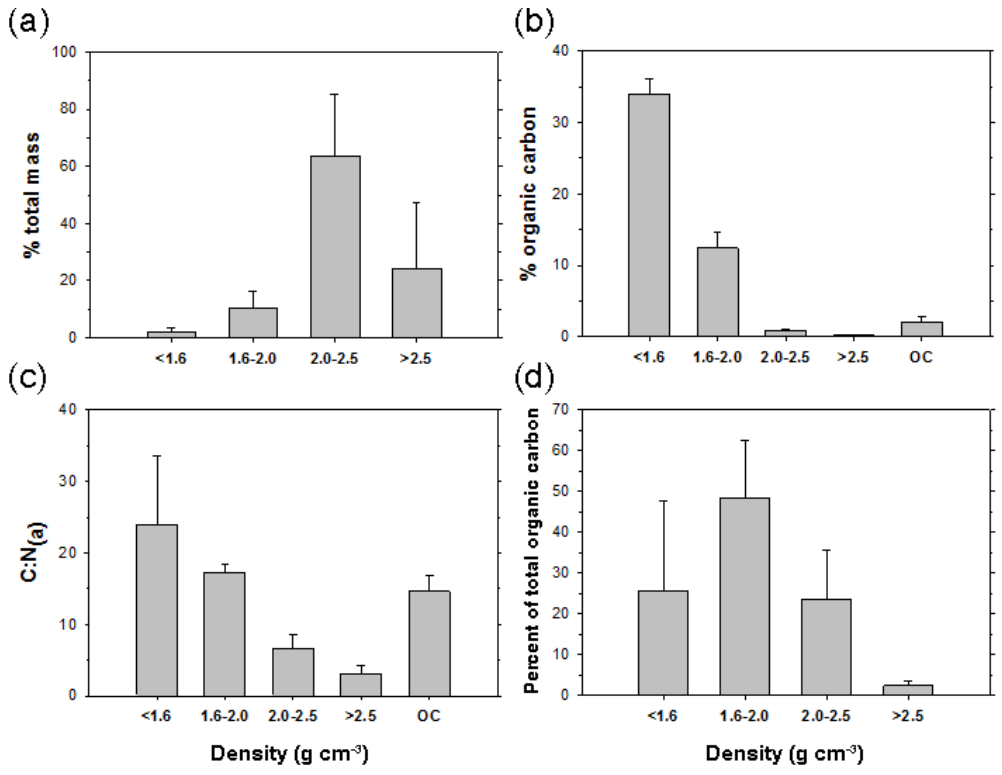
Figure 3. Mean and standard deviations of distributions of (a) mass, (b) organic carbon content, (c) atomic C:N ratio, and (d) percent of total organic carbon for each density fractions across the five study